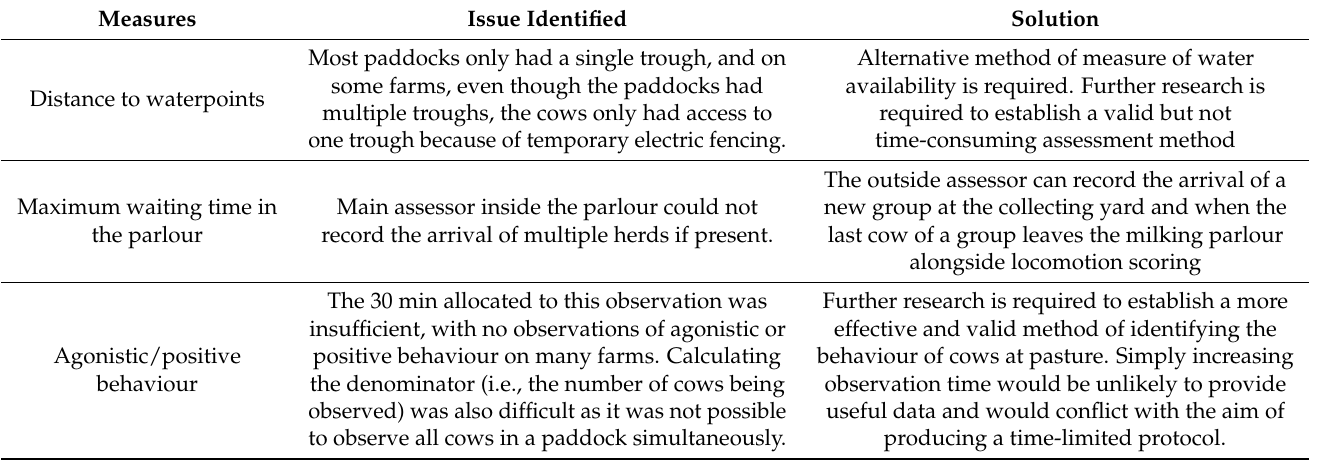
Table 5. Welfare measures found not to be feasible on all farms and reasons why they were not.